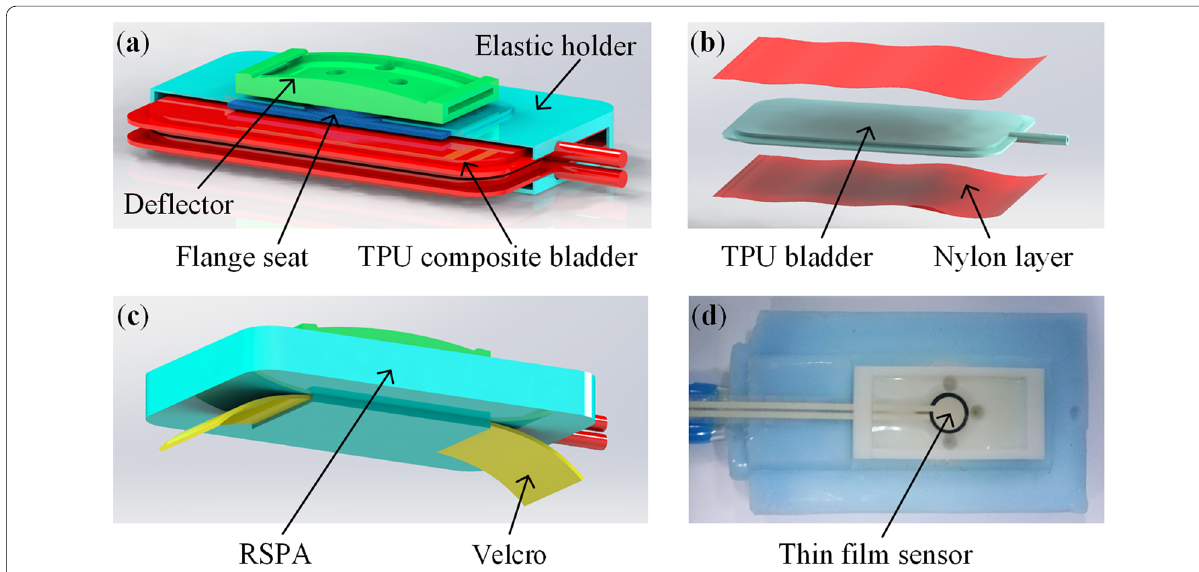
Figure 1 Structure of the RSPA: ( a ) Cross-section diagram of the RSPA, ( b ) Two nylon layers are laminated onto the surface of the TPU composite bladder, ( c ) The Velcro passes through the bottom channel of the RSPA to bond the RSPA to the wearable carrier, ( d ) A thin film sensor is installed in the center of the deflector